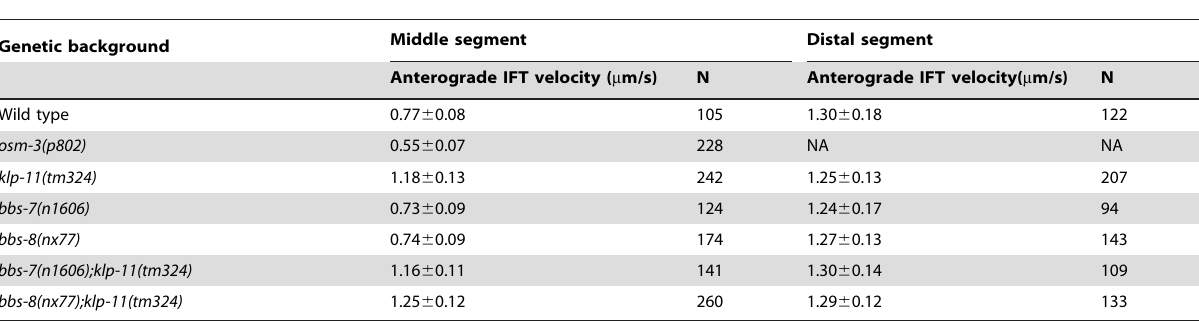
Table 3. XBX-1::YFP anterograde transport in different genetic backgrounds.